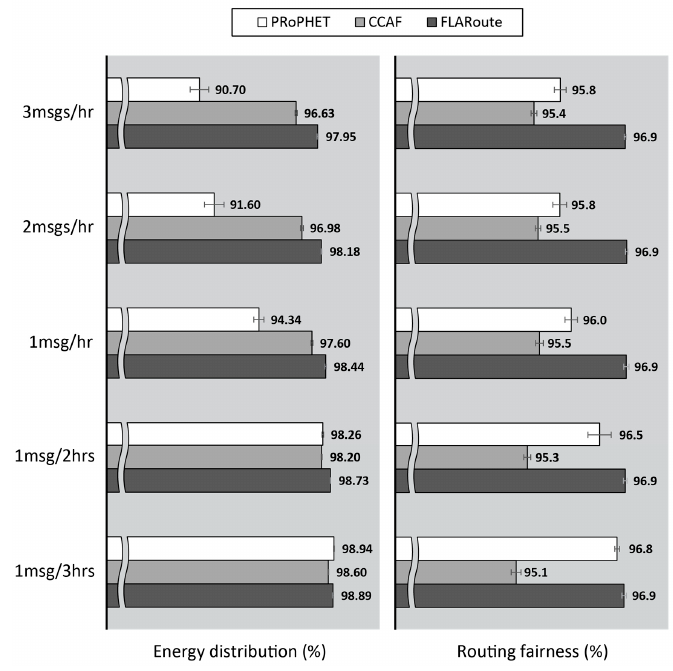
Figure 22. Energy distribution and routing fairness under increasing data traffic in the Helsinki scenario.